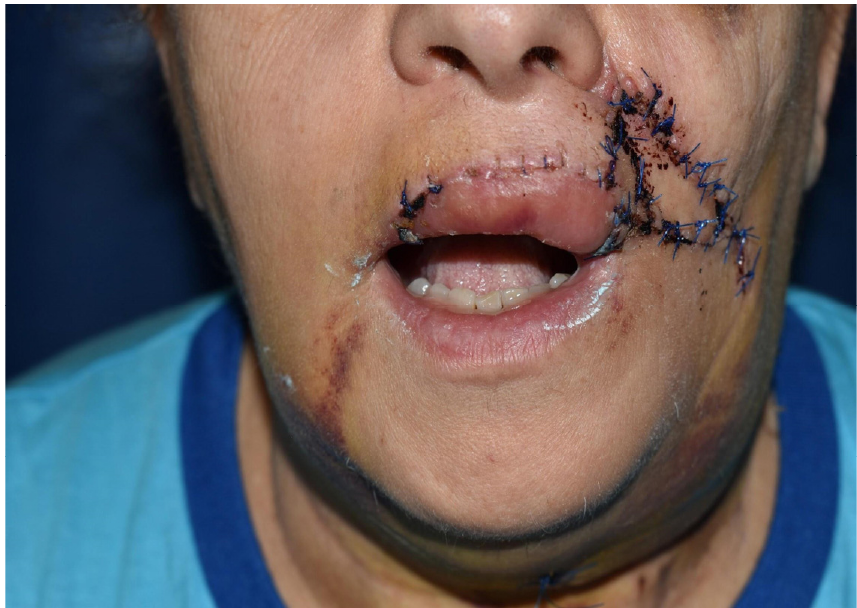
Figure 13. Case 6: Follow up at 8 days. Dinamic position, frontal view.